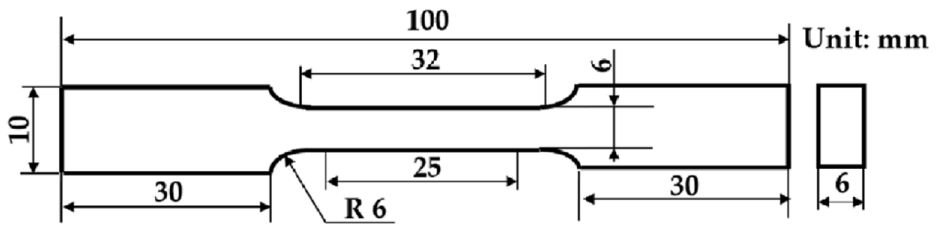
Figure 5. Dimensions of the ASTM E 8M-04 standard tensile specimen [22] .